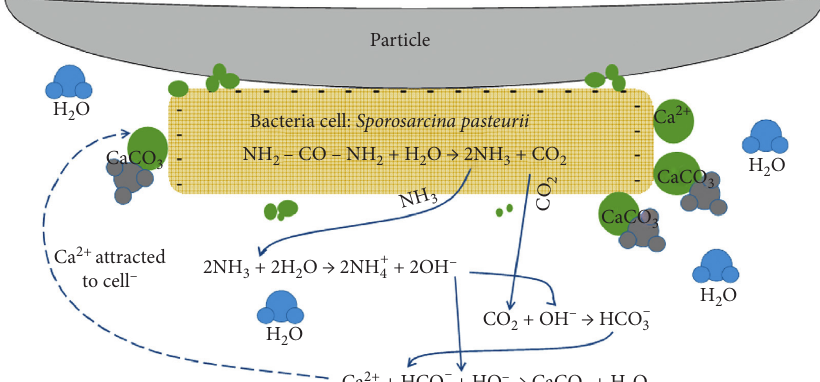
Figure 1: Schematic procedure of microbial-induced calcite precipitation (MICP).